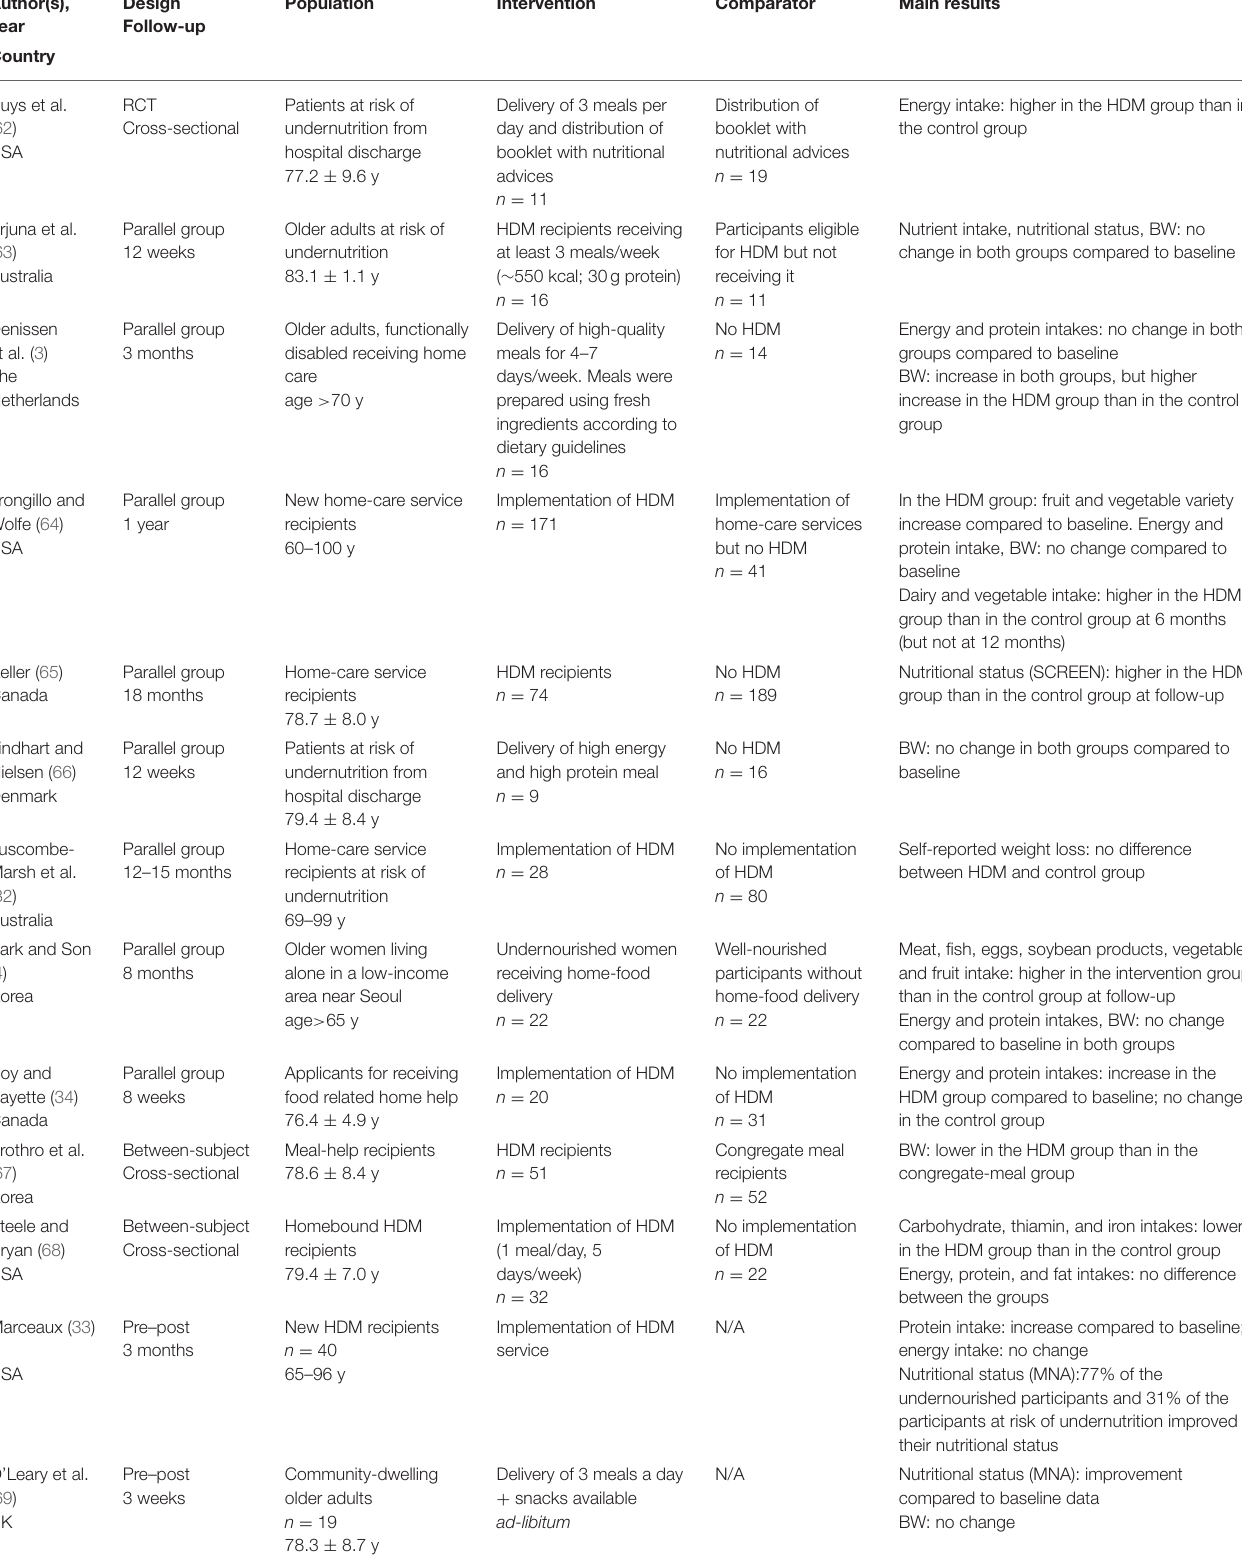
TABLE 4 | Comparison of nutritional outcomes between recipients and non-recipients of home-delivered meal